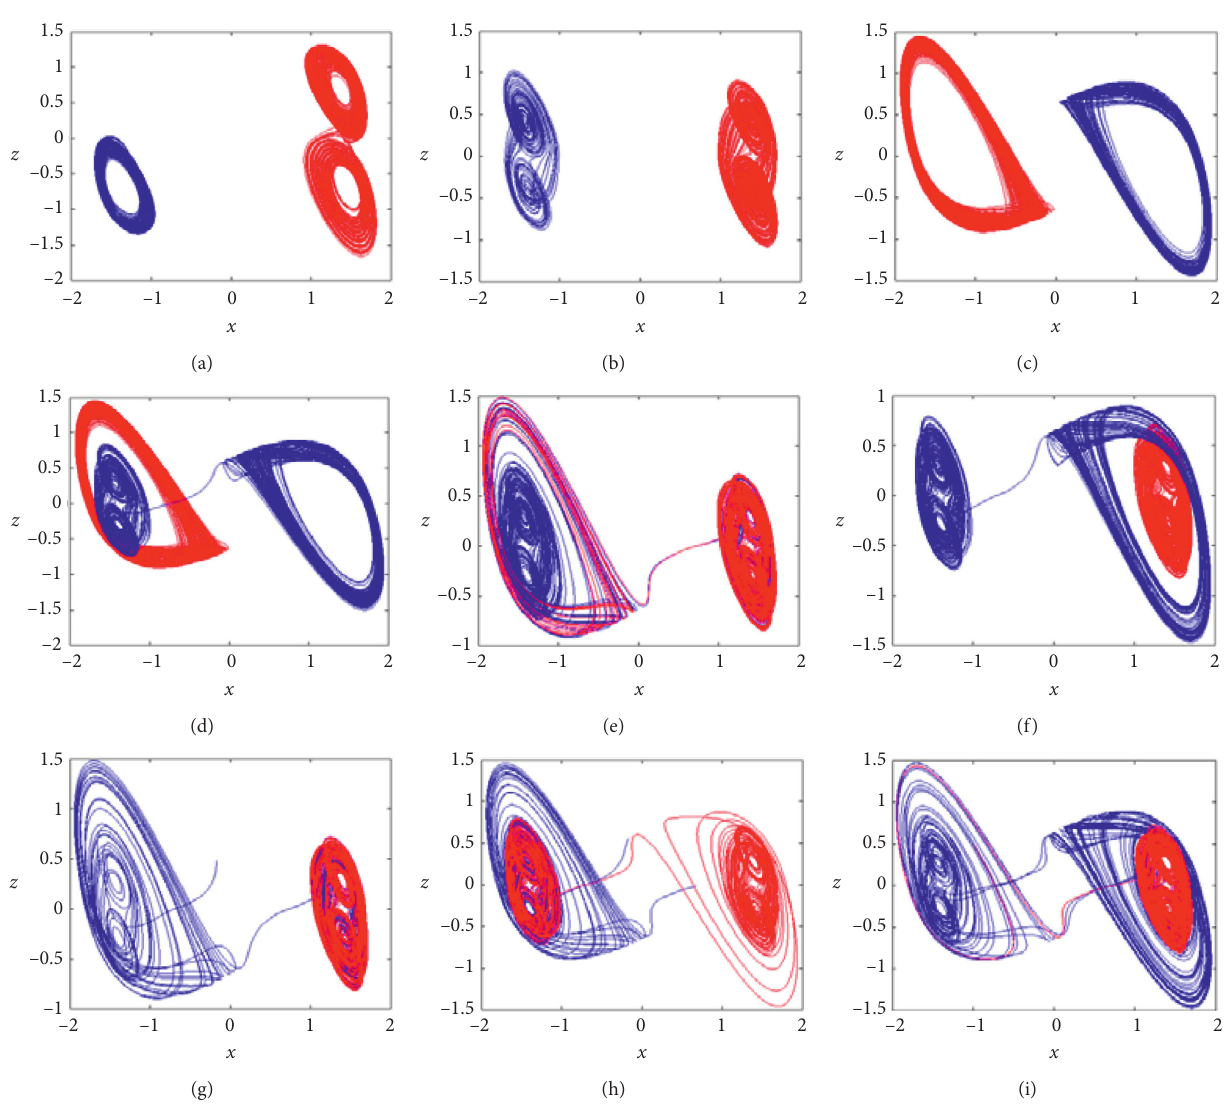
Figure 5: The coexisting chaotic or hyperchaotic hidden attractors with different values of parameter a .